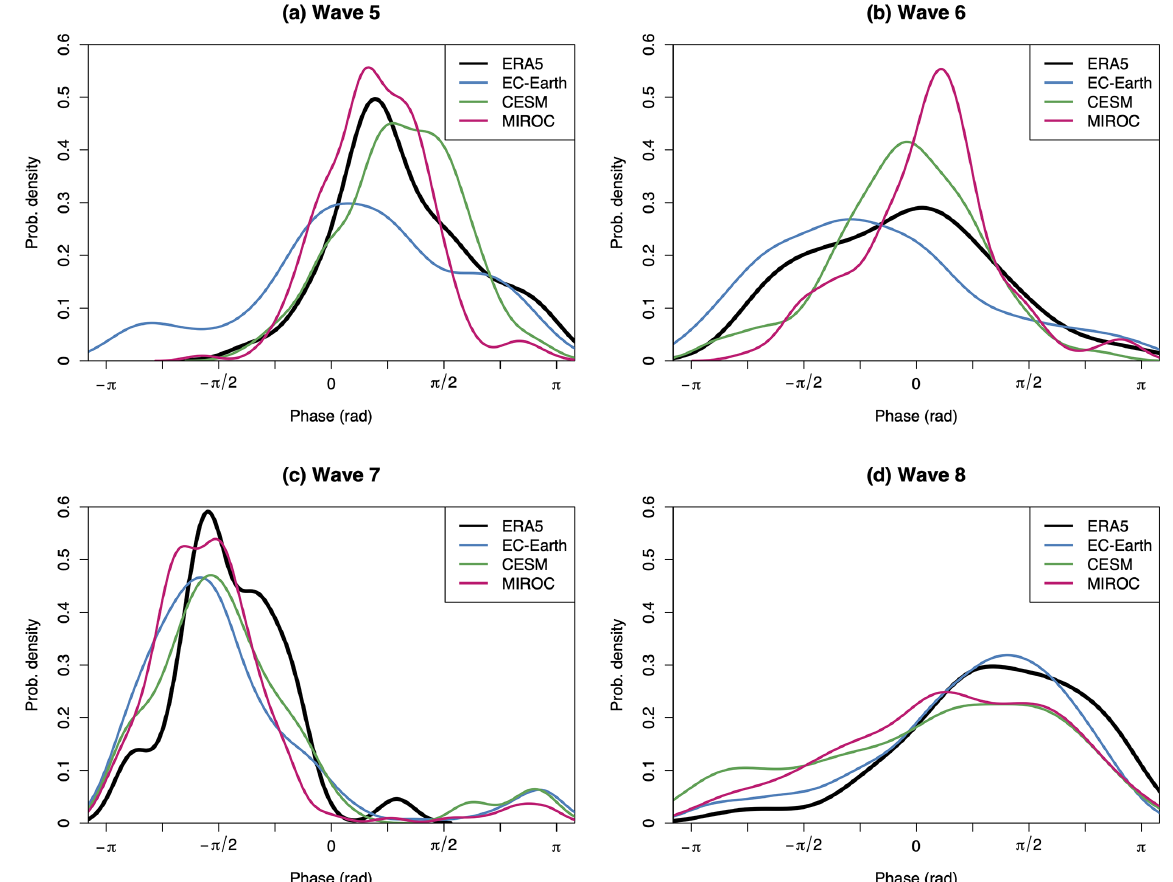
Figure 2. Phase locking of Rossby waves for JJA ERA5 and model waves 5–8 in control run AISI for high-wave-amplitude episodes ( > 1.5 SD). (a–d) Probability density functions of the phase positions of waves 5–8 in ERA5, EC-Earth, CESM, and MIROC during JJA for the period of 1979–2015/2016: wave 5 (a) , wave 6 (b) , wave 7 (c) , wave 8 (d) . The bandwidths for ERA5 and models are as follows. (a) Wave 5: 0.35(ERA5), 0.40 (EC-Earth), 0.25 (CESM), 0.22 (MIROC); (b) wave 6: 0.53 (ERA5), 0.45 (EC-Earth), 0.30 (CESM), 0.25 (MIROC); (c) wave 7: 0.25 (ERA5), 0.29 (EC-Earth), 0.27 (CESM), 0.22 (MIROC); (d) wave 8: 0.49 (ERA5), 0.39 (EC-Earth), 0.52 (CESM), 0.46